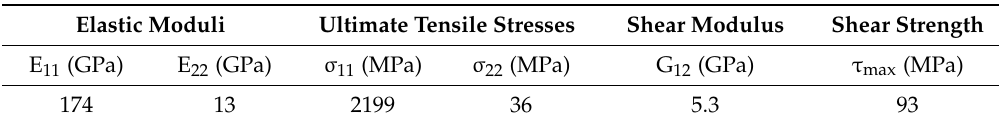
Table 1. Mechanical properties of the